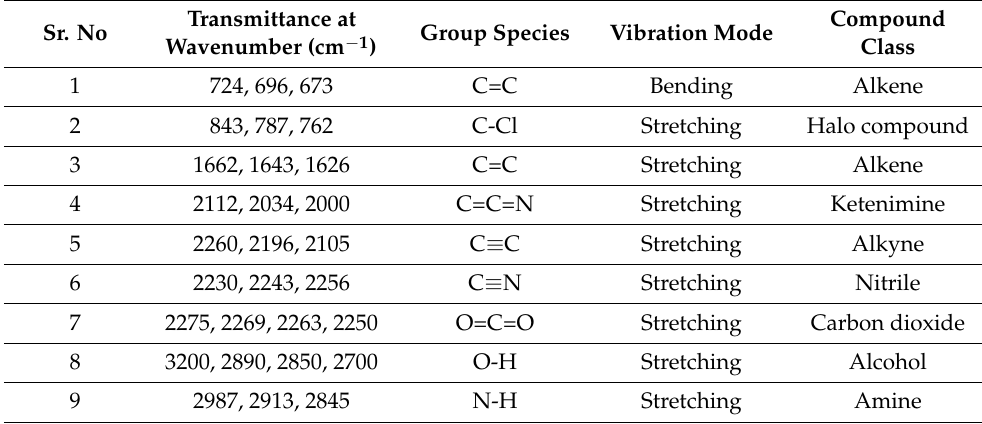
Table 2. FTIR analysis of the functional groups of degraded byproducts of DCF sodium by the Fe 2+ /PMS